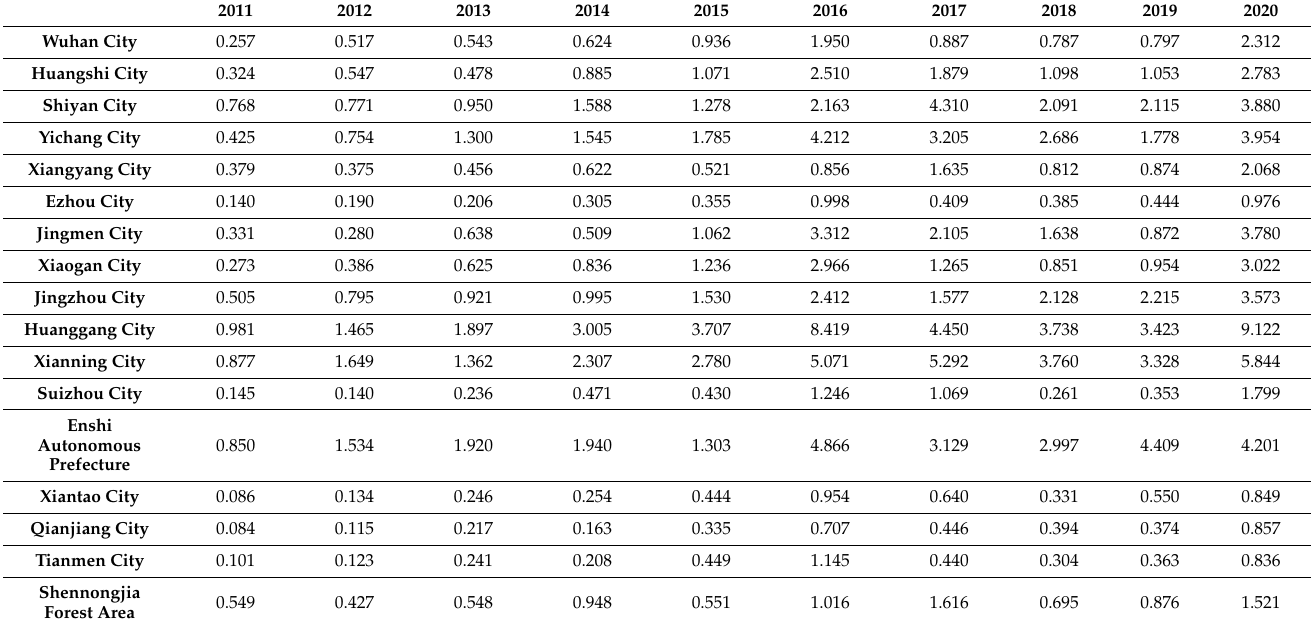
Table 6. Total liabilities of water resources in Hubei Province from 2011 to 2020 (billion USD).